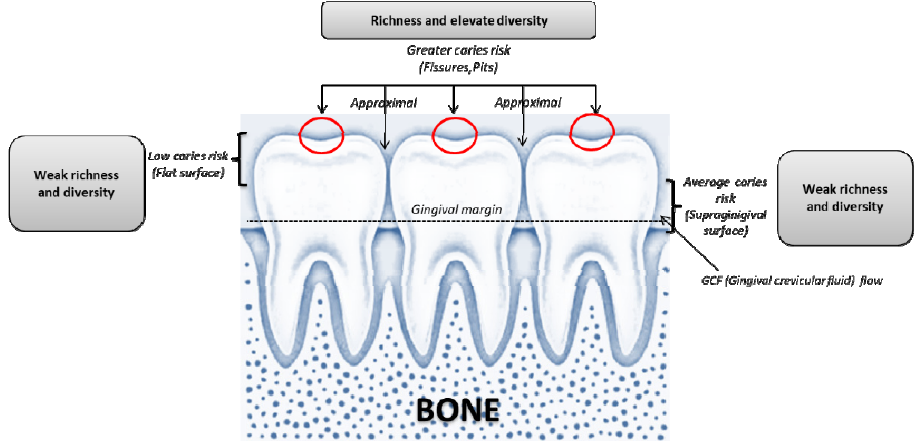
Figure 1. The risk associated with the areas that may be affected by caries and periodontal disease. Surfaces and locations with the highest variety and richness of oral microbial communities are more sensitive to caries and in the genital areas of periodontal disease. When tooth decay or periodontitis develops, the acidic environment reduces the variety and richness of local microbes.